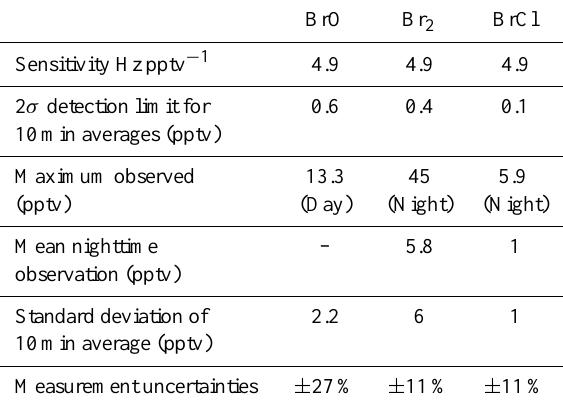
Table 1. Instrument parameters and overview of observations for BrO, Br 2 and BrCl for the period 12 August–18 September 2007. Details of measurements (max, mean, and standard deviation) for Br 2 and BrCl are based on nighttime observations only – see Sect. 3.2. Minimum values were below detection limits for all three